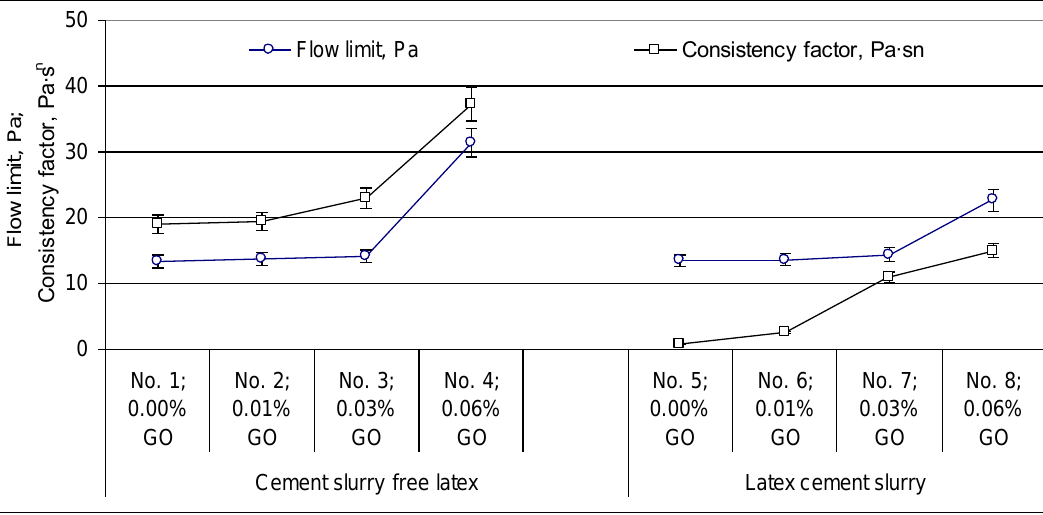
Figure 5. Casson’s viscosity and apparent viscosity change versus the graphene oxide (GO) concentration.